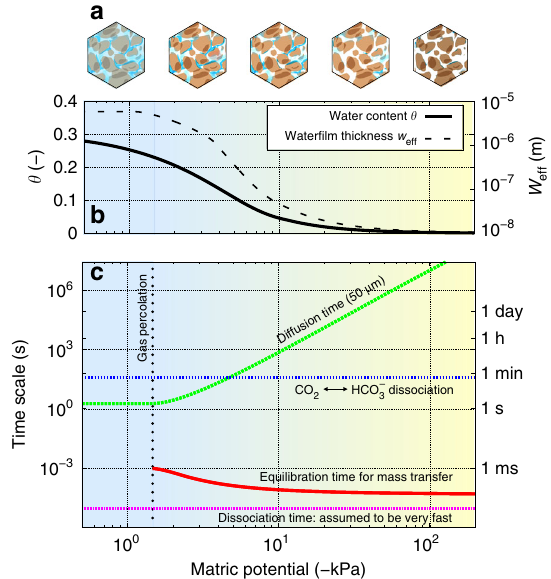
Fig. 2 Changes in abiotic conditions while drying soils. Model predictions of changes in abiotic conditions during drying of soils. a A schematics of changes in aqueous phase con fi gurations in soils during drying. b A typical model calculation of water content (black solid line) and effective water fi lm thickness (black dashed line) as a function of matric potential (blue- yellow gradient represents relative wetness). c A comparison of characteristic timescales for physicochemical processes relevant for local pH determination in aqueous fi lms for a range of hydration conditions (expressed as matric